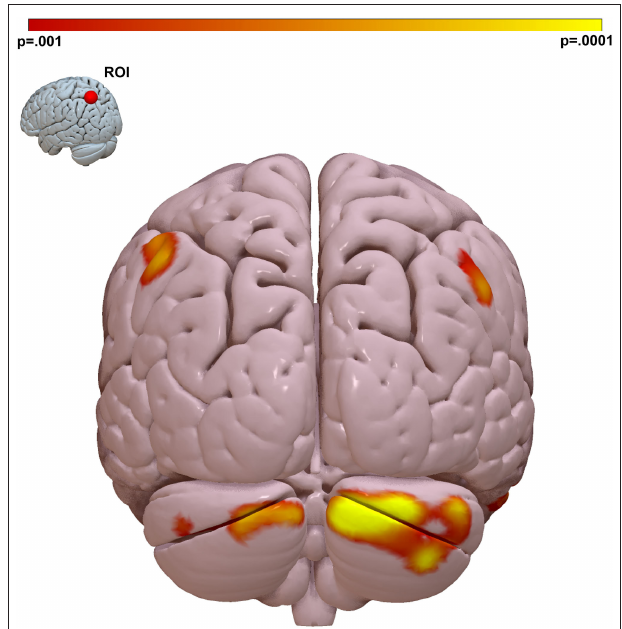
FIGURE 2 | The strongest link between connectivity and social cognitive ability is a parietal Lobe-cerebellar Crus I, II circuit. We visualized the spatial distribution of connectivity that gave rise to the MDMR result in Figure 1 . We placed a ROI in the left parietal region identified by MDMR and regressed connectivity to this region against MSCEIT-ME score. This identified the right cerebellar Crus I, II region as the region where functional connectivity correlates with social cognitive ability. Peak T -stat T = 4.99, p < 0.001, MNI x – 12, y – 90, z – 30. Cluster k = 695, p FWE < 0.001. Color bar =